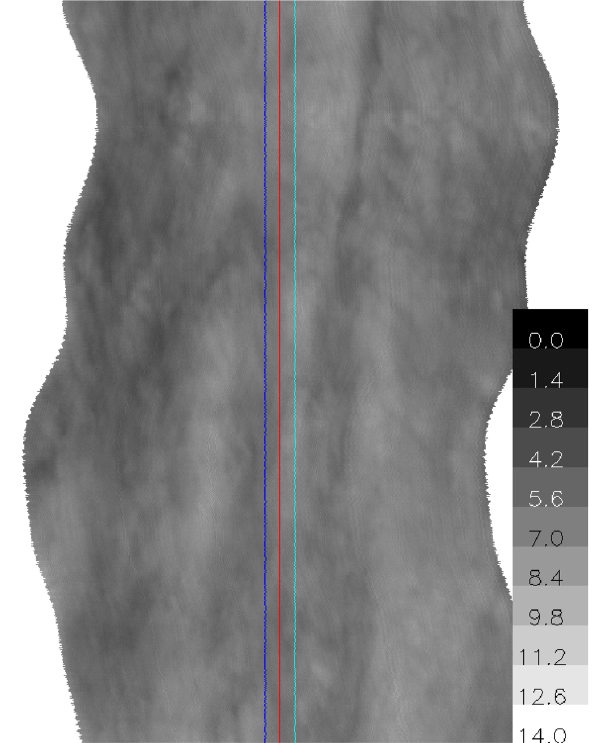
Fig. 11. Map of the cloud optical thickness as retrieved from radi- ances measured by the AisaEAGLE on 17 May 2010 at 10:14UTC. The red curve shows true nadir, the blue lines delineate the field- of-view of the SMART-Albedometer radiance. The depicted cloud field is 2km wide and 1km long. Each pixel shows a cloud area of 4m